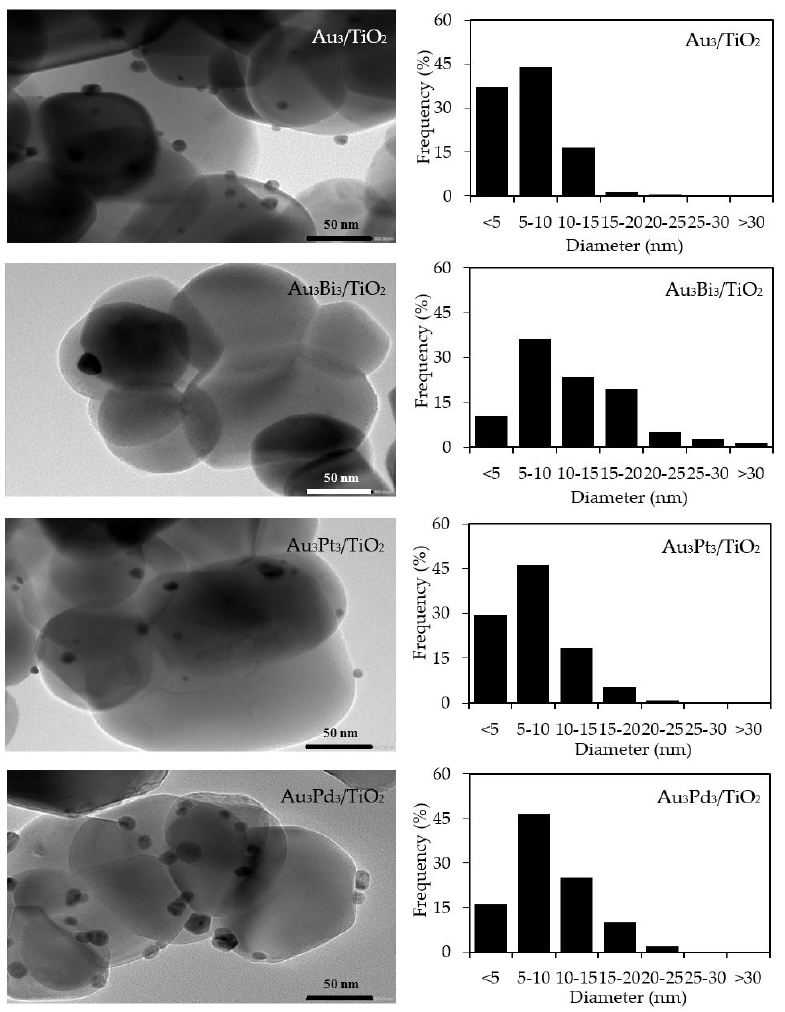
Figure 9. ( Left ) Representative TEM images of the Au 3 /TiO 2 and different Au 3 M 3 /TiO 2 photocatalysts and ( Right ) the derived respective AuM NP size distribution on the surface of the TiO 2 .